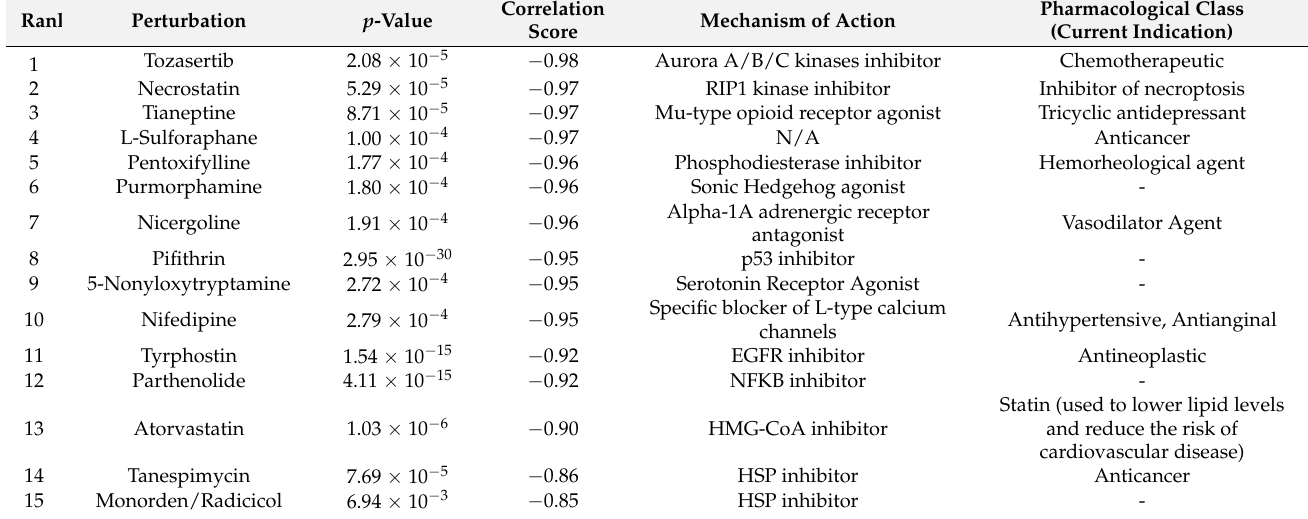
Table 4. List of the top 50 repurposable drug candidates with a potential to reverse apoptotic CGNs transcriptomic signature.